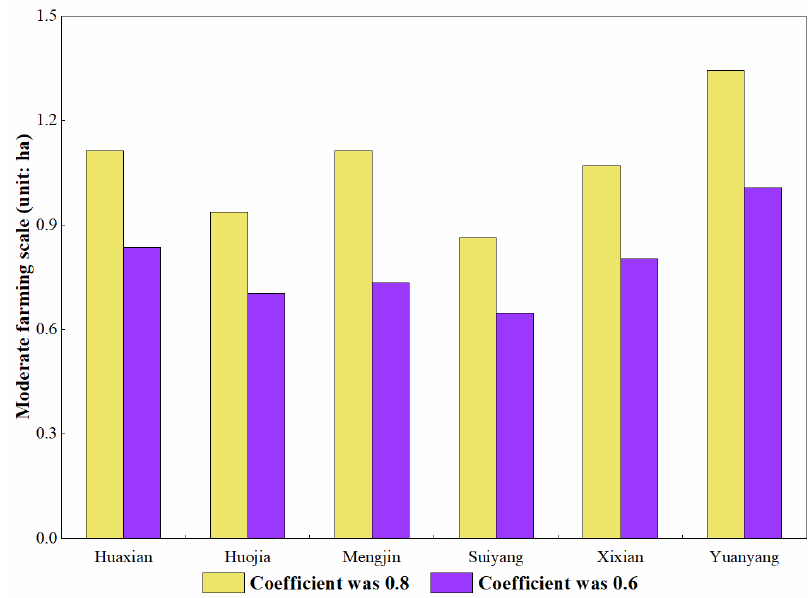
Figure 5. Corrected moderate farming scale.